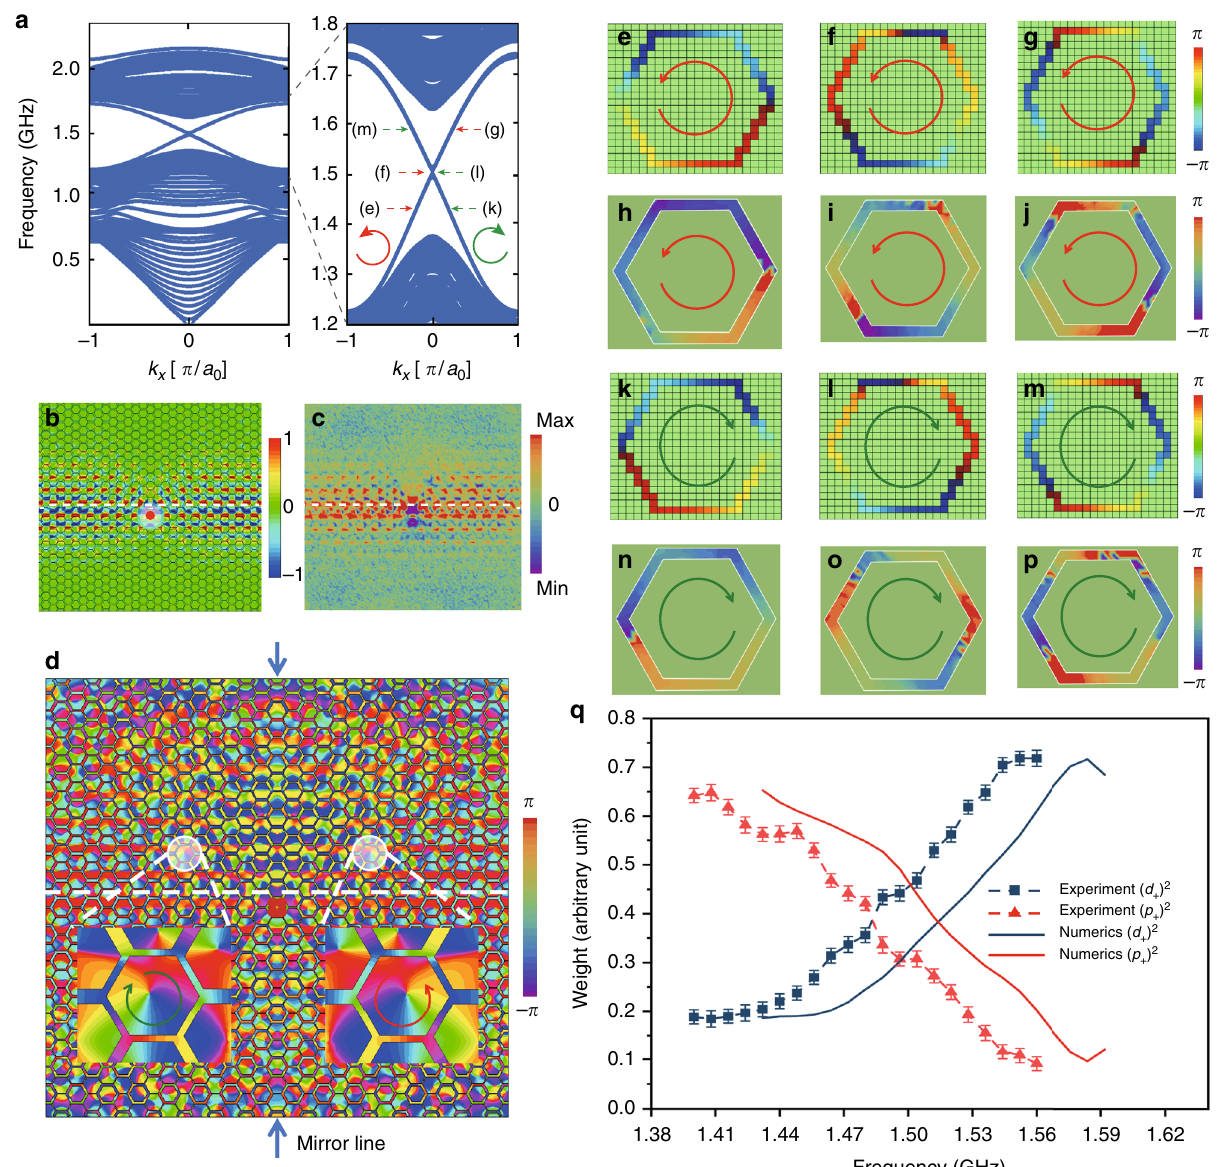
Fig. 3 Resolving pseudospin and p – d orbital hybridization. a Calculated frequency band structure for the whole system in Fig. 1b with an interface between the topologically trivial and nontrivial regimes. A supercell is adopted including 8 hexagonal unit cells on both sides of the interface where the parameters for Fig. 2a, c are taken, respectively. The system is considered in fi nite along the direction of the interface. The right panel is a zoomed-in view of the frequency band diagram around the bulk band gap at 1.515 GHz. The red/green arrow indicates the dispersion of the rightward/leftward-propagating interface mode. b , c Distributions of the out-of-plane electric fi eld E z obtained by the full-wave simulations ( b ) and experimental measurements ( c ) using a linearly polarized source located at the interface. The source frequency is set at f = 1.47 GHz for the full-wave simulations and f = 1.44 GHz for experimental measurements. d Phase distribution of the out-of-plane electric fi eld E z under the same condition as ( b ) which is mirror symmetric with respect to the mirror line perpendicular to the interface indicated by the two dark-blue arrows. The source is located on the mirror line. The two insets show zoomed-in views of the phase distributions in the two typical hexagonal unit cells close to the interface, with the left/right one accommodating clockwise/counterclockwise phase winding. e – g , h – j Full-wave simulated and experimentally measured phase distributions in the right highlighted hexagon in ( d ) with up pseudospin at three frequencies indicated in the right panel in ( a ). k – m , n – p Same as those in ( e – g ) and ( h – j ), respectively except for the left highlighted hexagon in ( d ). q Frequency dependence of weights of p and d orbitals obtained by the full-wave simulations and experimental measurements for the right hexagonal unit cell in ( d ). The p and d orbitals take the same weight at the frequency where the two interface frequency dispersions cross each other in ( a ), with an apparent difference of 0.03 GHz between the simulated and experimental results. The error bars indicate statistical uncertainty (standard deviation) during three